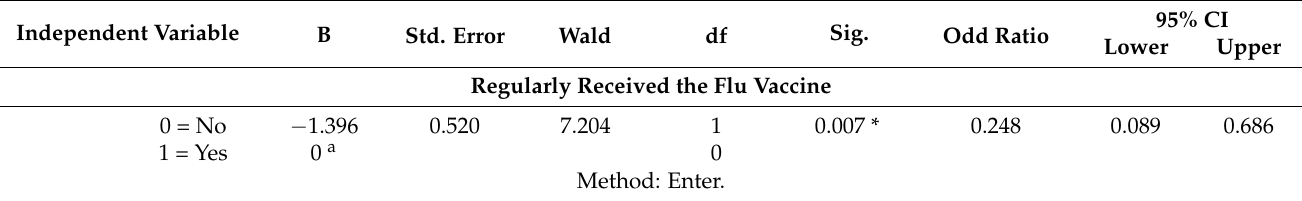
Table 4. Binary logistic regression analysis on factors significantly associated with the acceptability of the COVID-19 vaccine. Independent